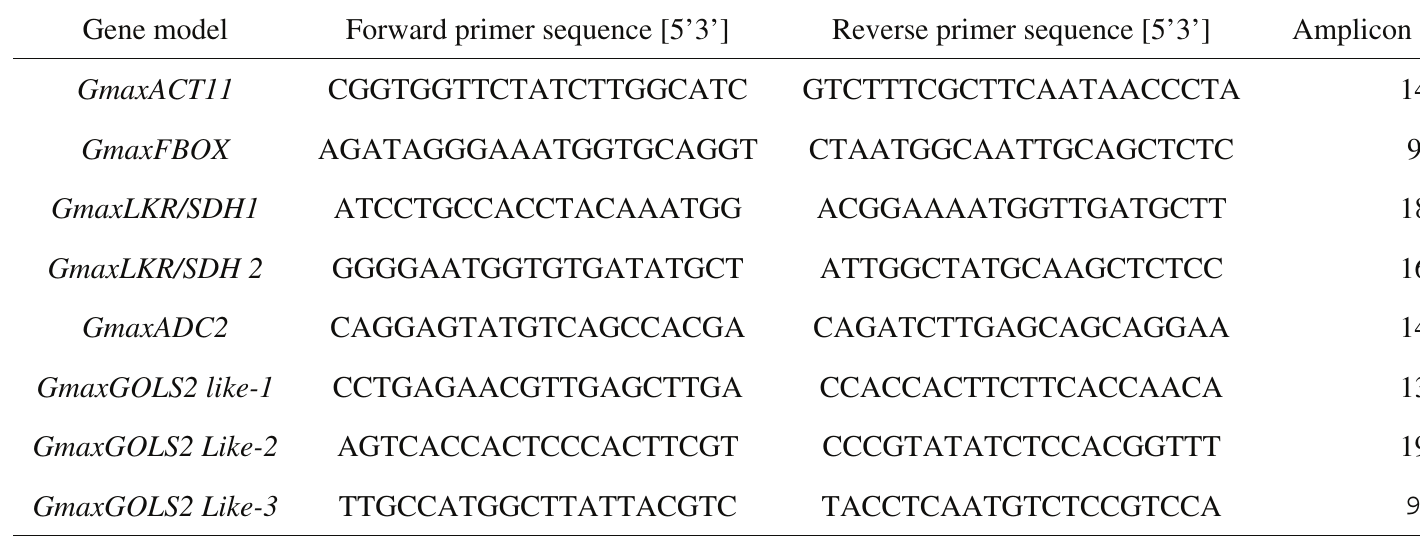
Table S1 - Sequences and features of primers used in this